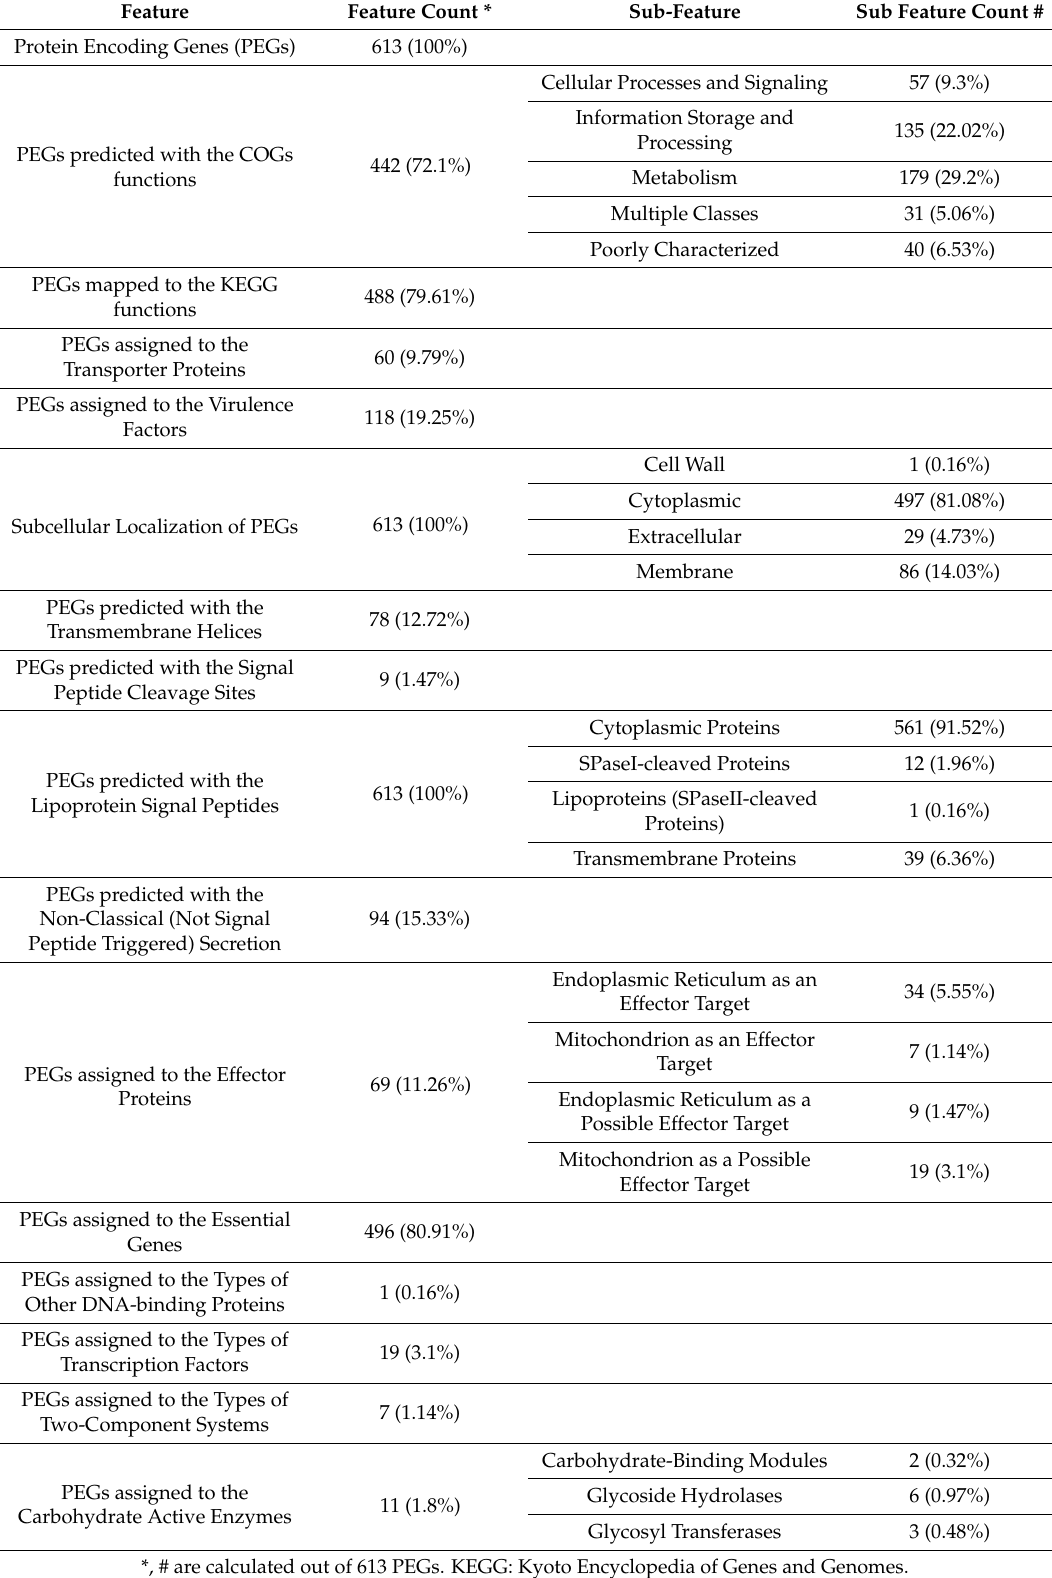
Table 2. Summary of the genomic and functional features of the core-genome of the 56